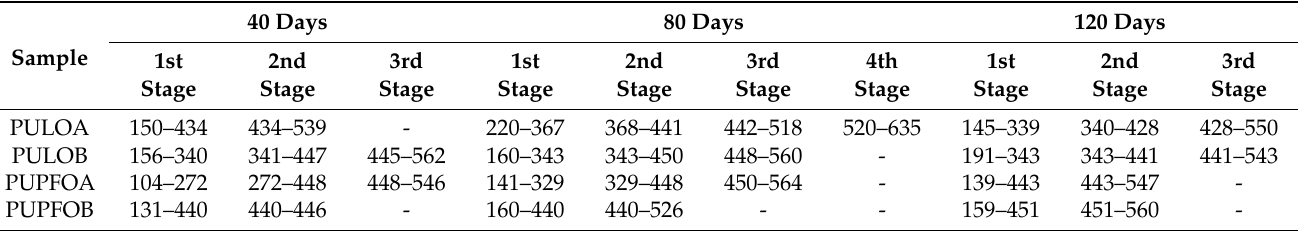
Figure 9. Thermal analysis curves: PULOA ( a ) TG and ( b ) DTG; PULOB ( c ) TG and ( d ) DTG. Heating rate: 10 ◦ C · min − 1 . Table 2. Temperature ranges (in ◦ C) of the studied materials and thermal decomposition stages for 40, 80 and 120 days of soil